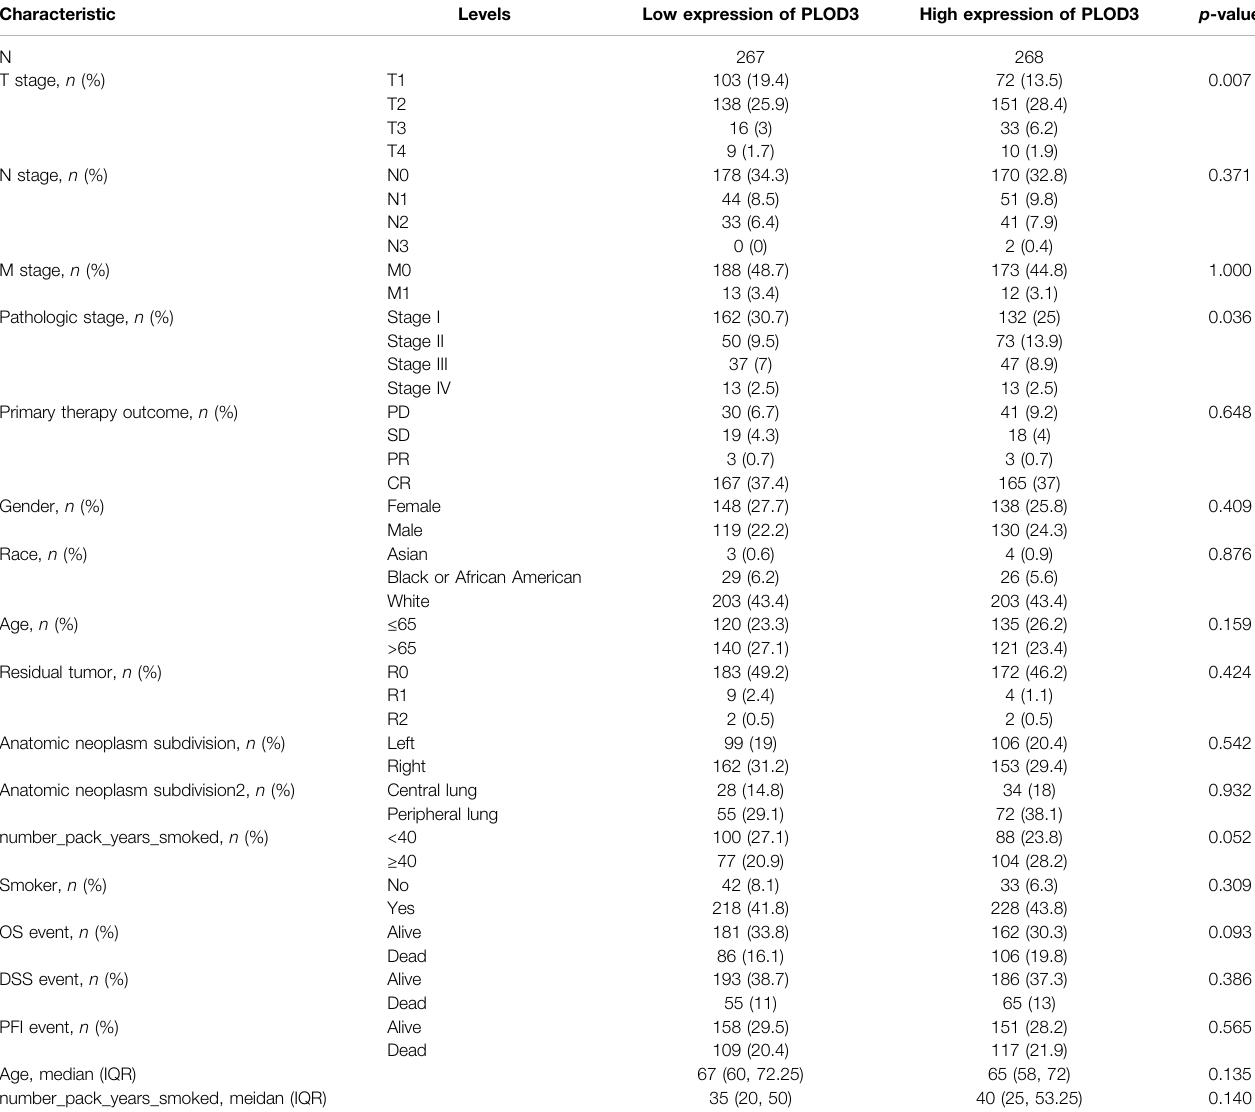
TABLE 3 | Clinical characteristics of the LUAD patients (TCGA) Characteristic Levels Low expression of PLOD3 High expression of